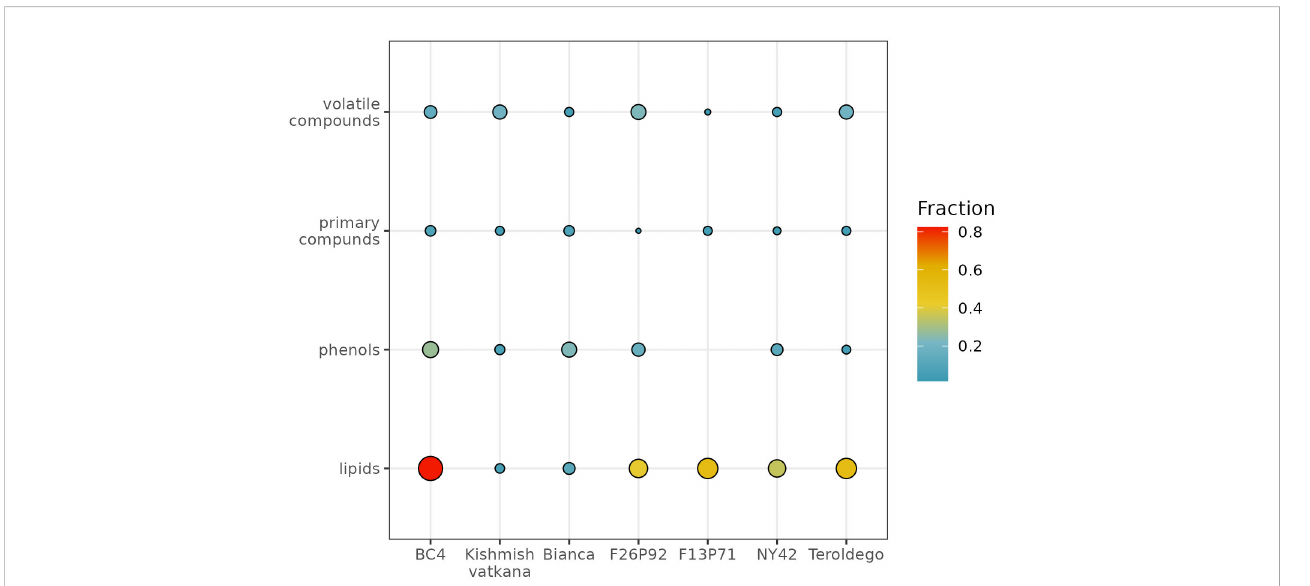
FIGURE 4 Global visualization of highly modulated metabolites by chemical class (in percentage) in response to E. necator inoculation. The size and color intensity of the dots are proportional to the estimated percentage of metabolites modulated in each genotype in both years, based on the total number of identi fi ed and quanti fi ed/semi-quanti fi ed metabolites per